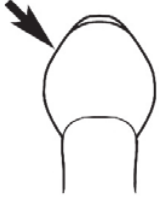
28 Head of minor worker conspicuously dorso-ventrally compressed (seen in profile, head width < 0.5 × head length); anterior clypeal margin evenly convex (northern Kimberley, northern NT) (major worker unknown) ............... tenuis – Head of minor worker not conspicuously dorso-ventrally compressed (seen in profile, head width > 0.5 × head length); anterior clypeal margin with a medial notch or crenulation ...................................................................... 29 29 In profile, pronotum of minor worker flattened; in dorsal view, pronotum of minor worker moderately attenuated anteriad; black, very gracile species (one pin only of two damaged minor workers from Mullewa, WA) (Fig. 16a–d) ........